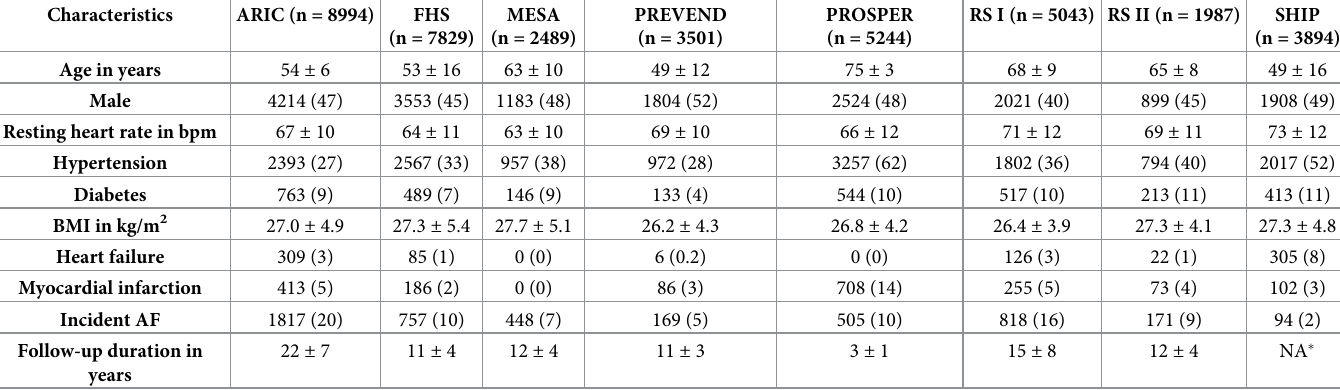
resting heart rate was 67 ± 11 bpm on baseline ECGs. A total of 4,779 (12%) individuals devel- oped AF during a mean follow-up period of 13 ± 5 years. Table 1 shows baseline characteristics of participating cohorts. Table 1. Characteristics of individuals of European ancestry included in the participating cohorts of